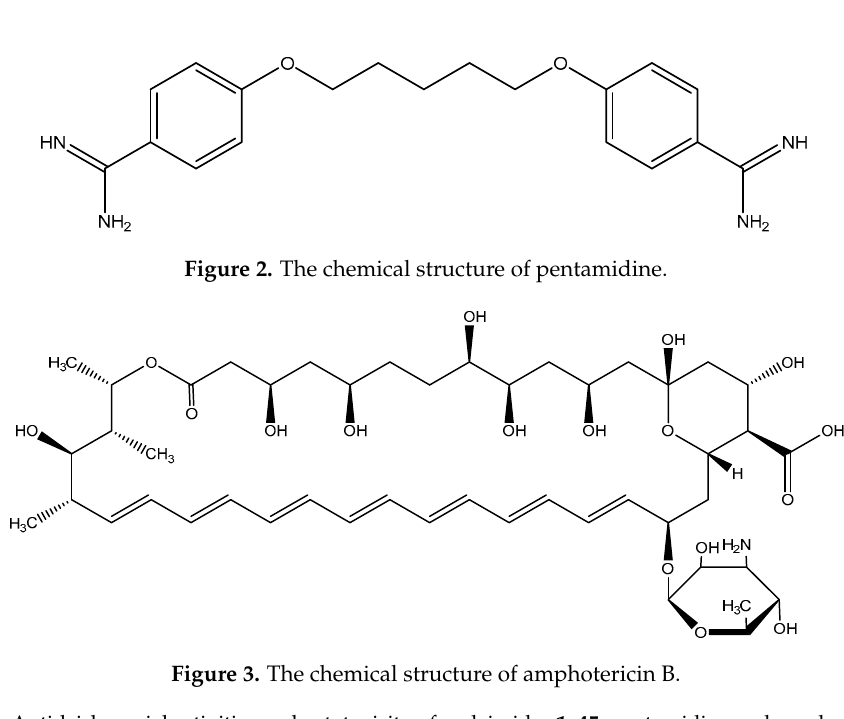
Figure 1. Chemical structures of the studied N -substituted maleimides.